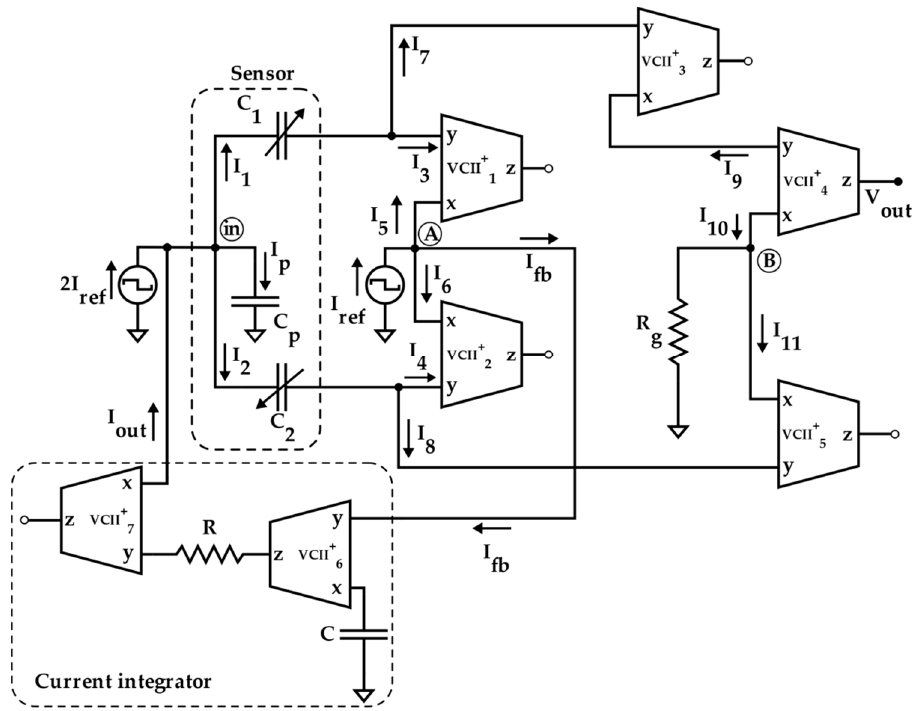
Figure 3. The proposed second-generation voltage conveyors VCII based interface.